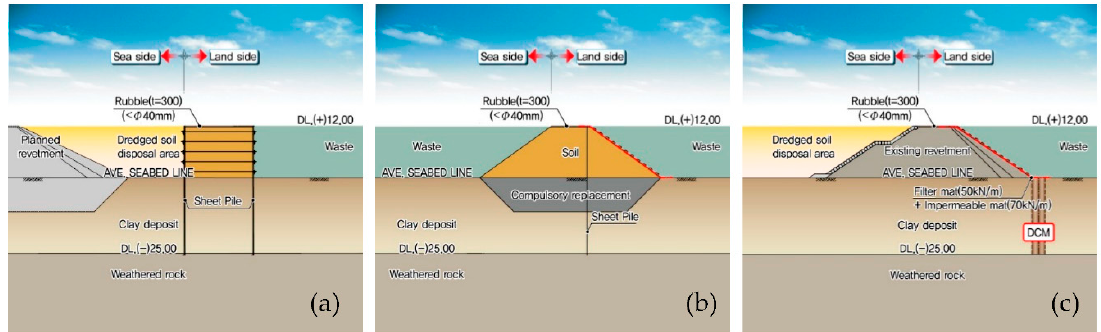
Figure 5. Cross-sections of the revetments constituting the offshore waste disposal facility: ( a ) the barrier revetment corresponding to Sections A – E; ( b ) the separating revetment corresponding to Section I; and ( c ) the connection revetment corresponding to Section L.